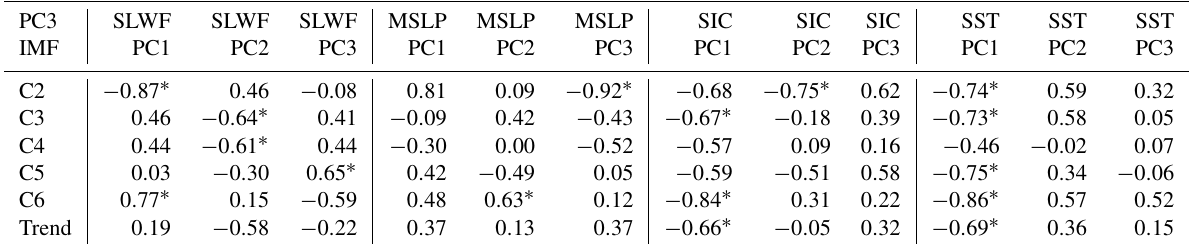
Table 4. The correlations between the third EOF sea ice drift pattern on various timescales and environmental factors (the PCs with the highest correlation values greater than 0.6 are marked with an asterisk).